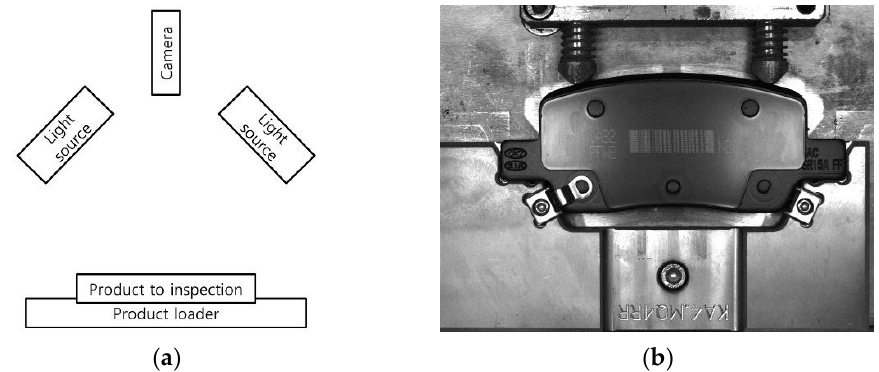
Figure 3. ( a ) System configuration and ( b ) captured image of the brake pad.